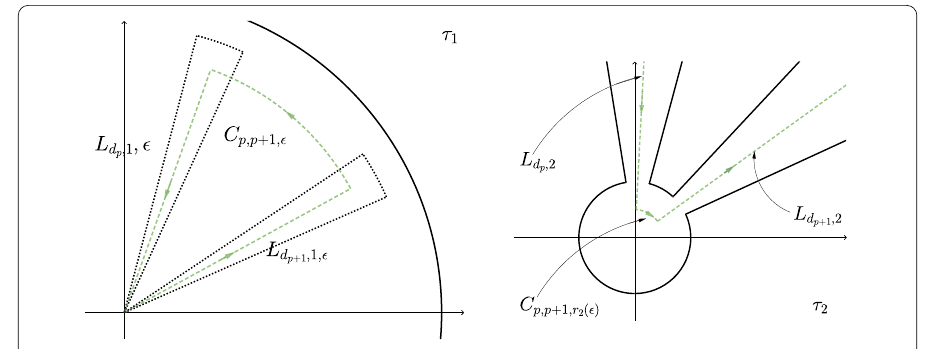
Figure 1 Deformation of the paths involved in the proof of Theorem